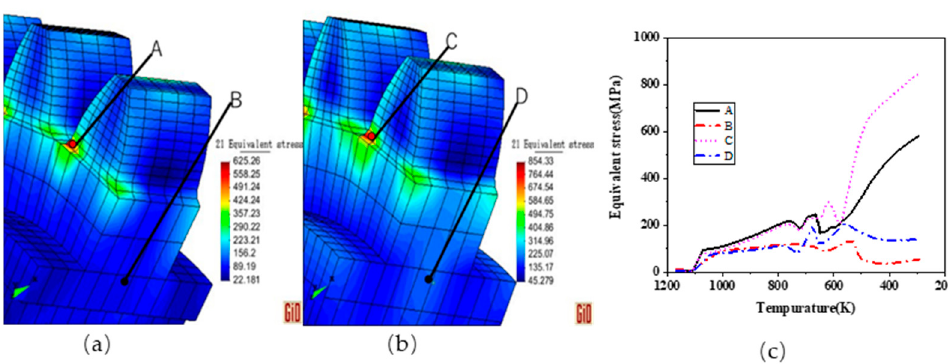
Figure 14. Equivalent residual stress results for 20MnCr5 steel gears: ( a ) with transformation plasticity; ( b ) without transformation plasticity; ( c ) equivalent residual stress depending on tempera- ture.